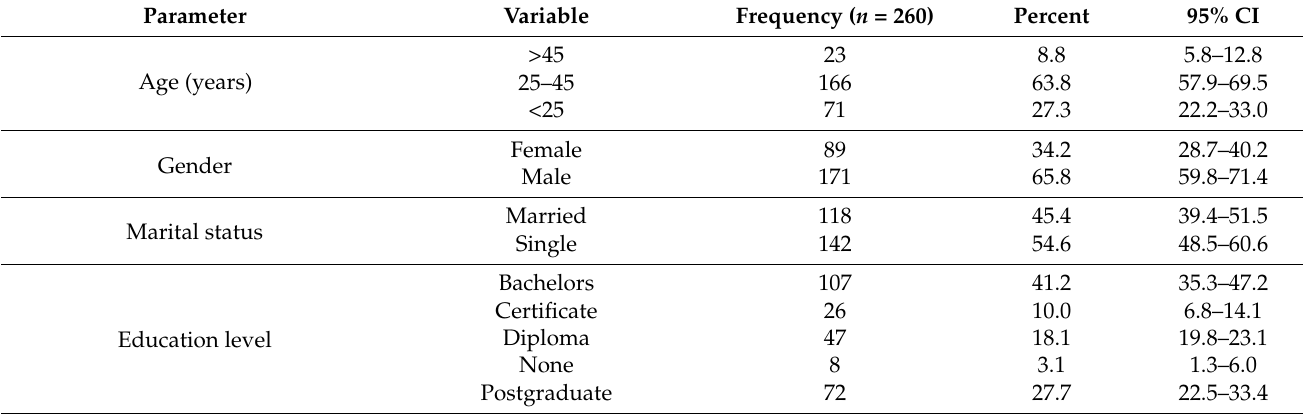
Table 1. Statistic on sociodemographic variables in the study